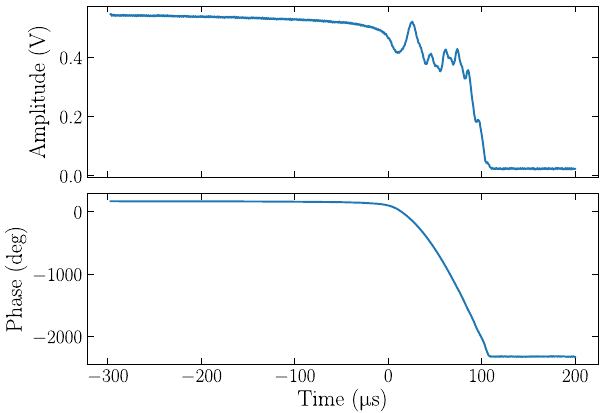
FIG. 7. The amplitude (upper graph) and phase (lower graph) of the beam signal, respectively. These data were deduced from the measured IQ signals in Fig.